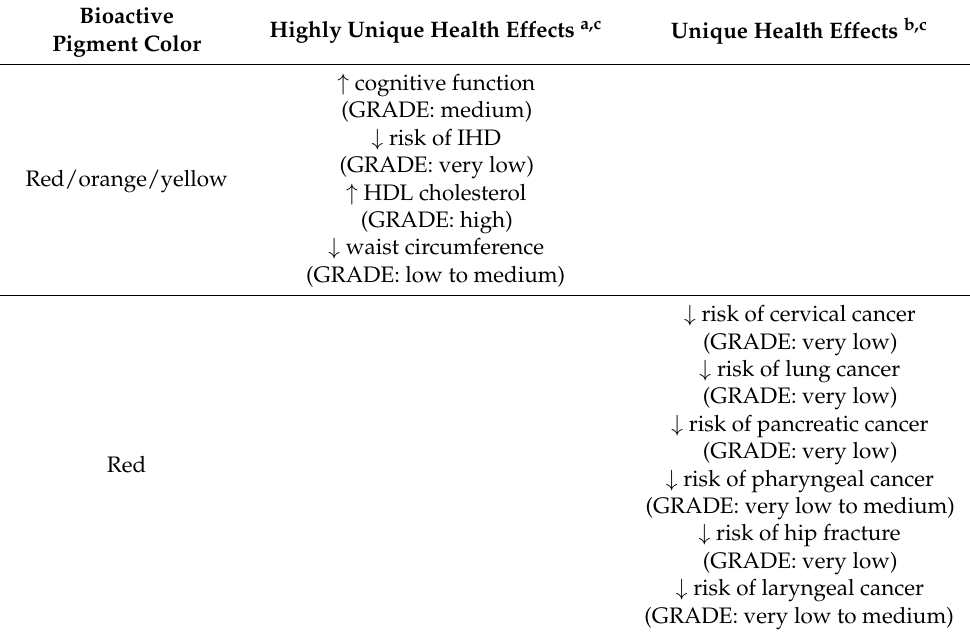
Table 2. Unique health effects of bioactive pigment colors found in fruit or